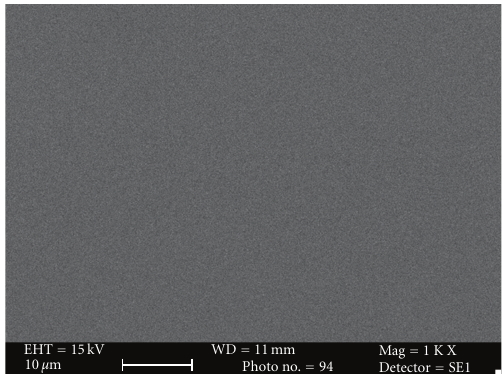
Figure 5: Photomicrograph of Esthet X after bleaching at